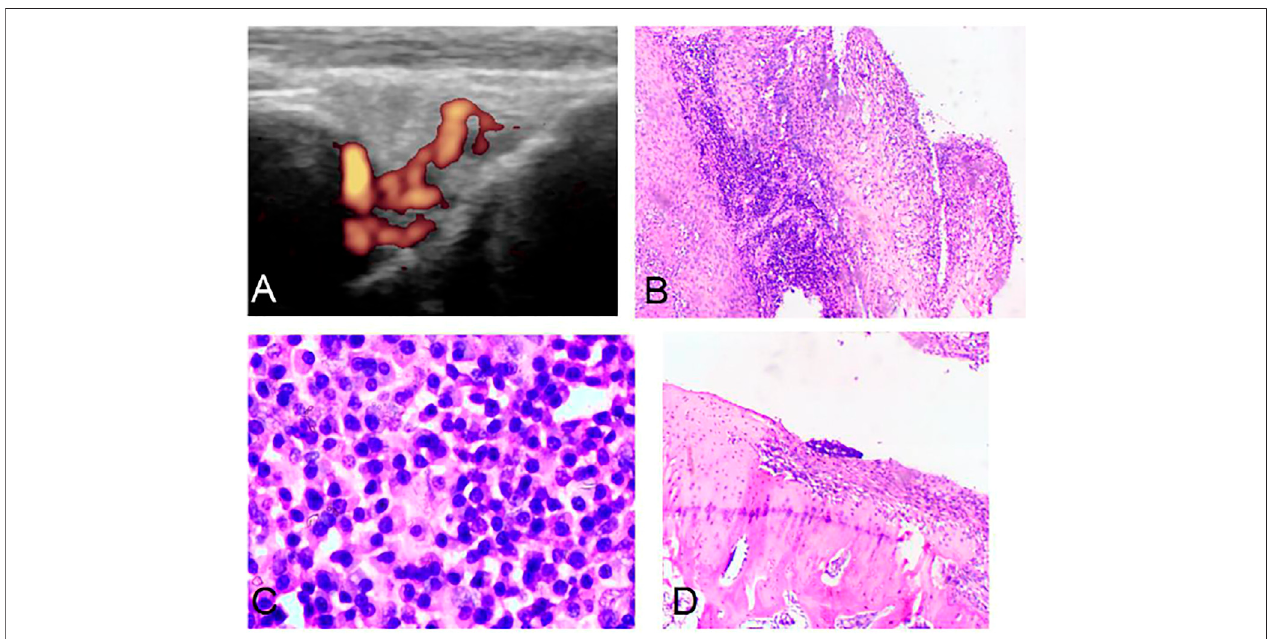
FIGURE 1| Ultrasound and pathology ofAIA model. Synovitis and high blood fl ow signals observed by Power Doppler Ultrasound (A) . Synovitis and in fl ammatory cell in fi ltration can be observed by pathology (B) (HE, 40×). Large amount of plasma cell in fi ltration (C) (HE, 200×). Extensive bone destruction on the bone surface (D) (HE,